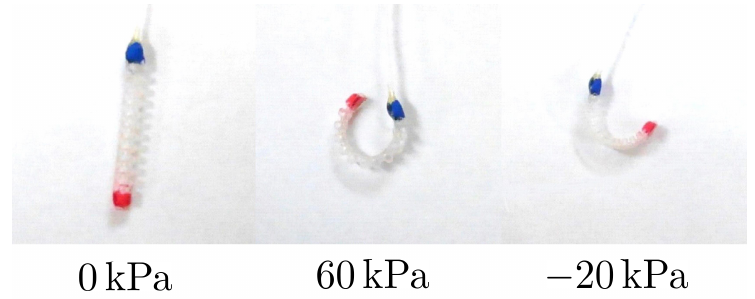
Figure 2. The bending motion of the actuator.